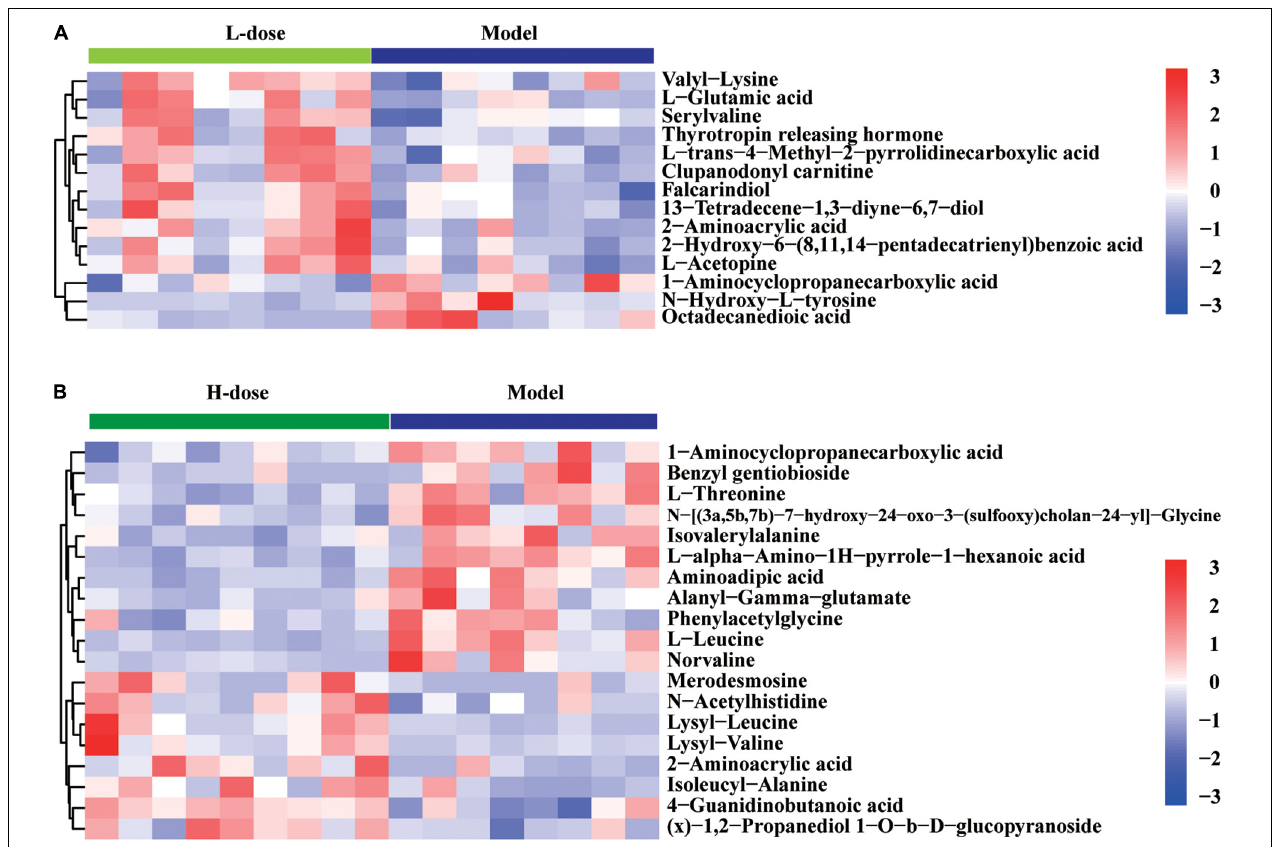
FIGURE 6 | The changed amino acids and bile acids in GDM rats treated with probiotics supplements. (A) Hierarchical clustering analysis of 14 amino acids and bile acids in GDM rats treated with low-dose probiotics supplements vs. GDM rats. (B) Hierarchical clustering analysis of 19 amino acids and bile acids in GDM rats treated with high-dose probiotics supplements vs. GDM